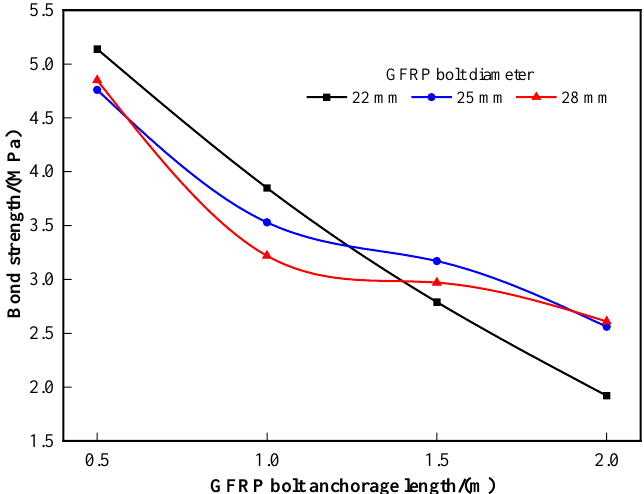
Figure 5. Relationship between anchorage length and bond strength.